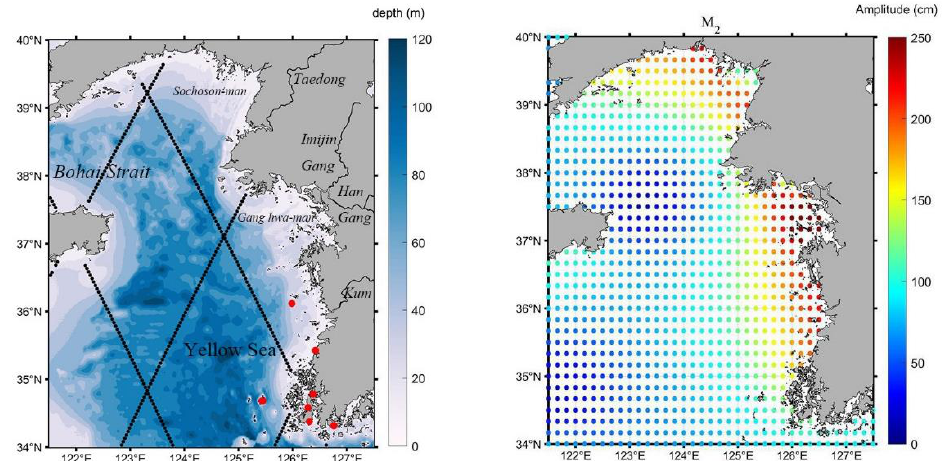
Figure 1. The altimetry satellite tracks of the X-TRACK satellite observation ( left ), and the amplitude of M 2 calculated by the adjoint assimilation model ( right ). The red dots in the left subfigure are the positions of eight tidal gauges. Daeheugsan (34.68° N, 125.45° E), Usuyong (34.58° N, 126.28° E), Mokpo (34.78° N, 126.38° E), Eocheongdo (36.12° N, 125.98° E), Yeonggwang (35.43° N, 126.42° E), Wando (34.32° N, 126.76° E), Jindo (34.38° N, 126.31° E), and Heuksando (34.68° N, 125.44° E).